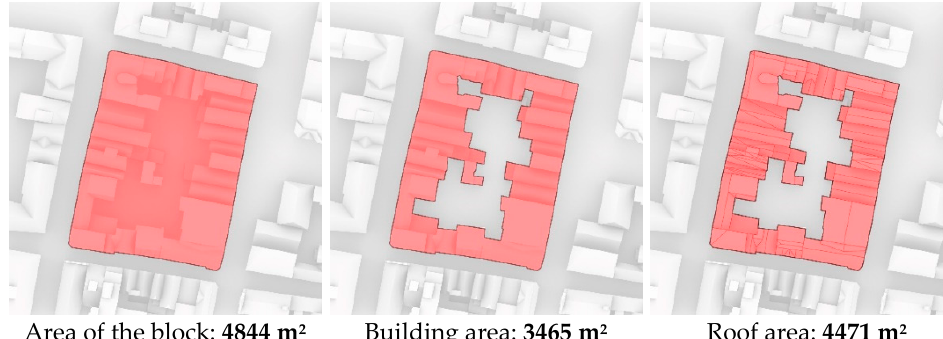
Energies 2022 , 15 , 6296 Figure 10. Analysis of surface area in the building block. Figure 10. Analysis of surface area in the building block.